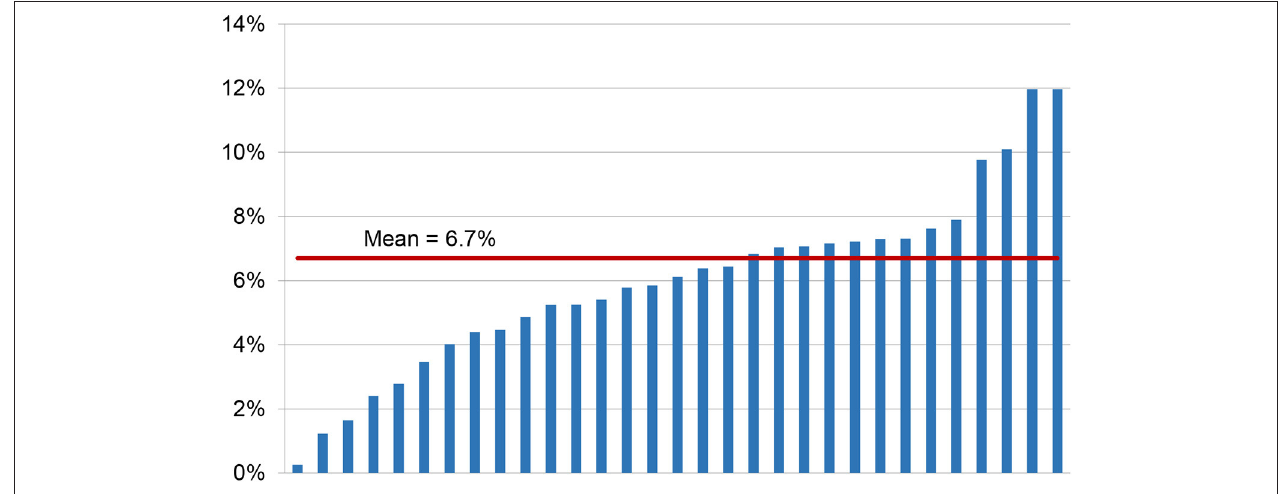
FIGURE 1 | Percentage of cases with mechanical restraint or seclusion measures for the 31 hospitals in